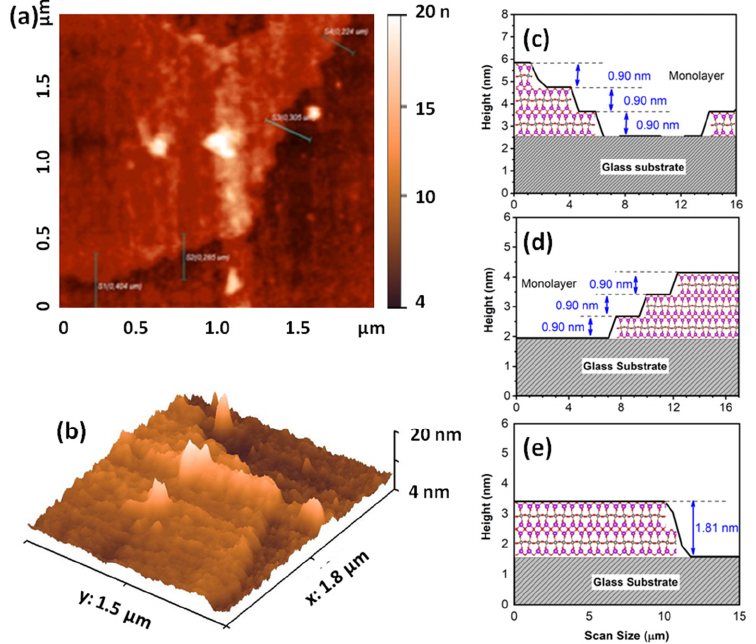
Figure 2. AFM images of the layered Bi 2 WO 6 nanosheets: ( a ) Surface topography, ( b ) three- dimensional image and ( c – e ) the corresponding height